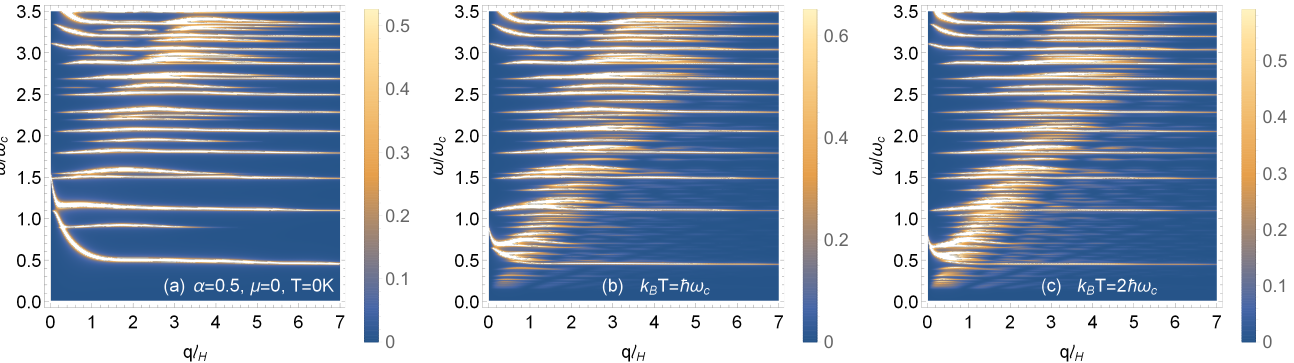
Figure 8. Density plots of the magnetoplasmon dispersion relation for various temperatures ( a – c ). The hopping parameter is α = 0.5 and the chemical potential, µ = 0, is set at the top of the flat band.